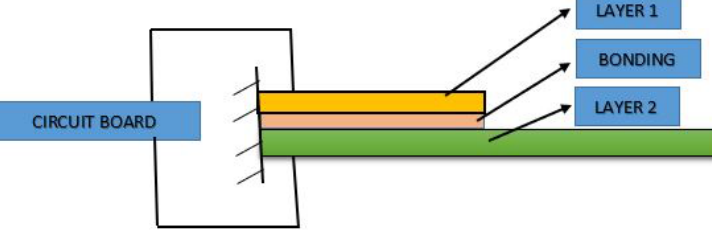
Figure 18. Cantilever beam mechanism-based piezoelectric energy harvesting